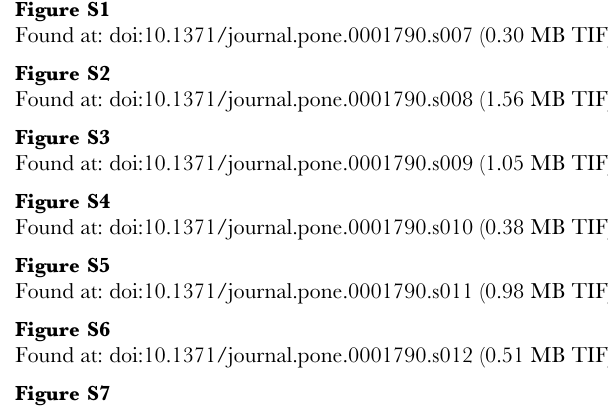
Figure S8 Found at: doi:10.1371/journal.pone.0001790.s014 (0.93 MB TIF) Figure S9 Found at: doi:10.1371/journal.pone.0001790.s015 (0.72 MB TIF) Figure S10 Found at: doi:10.1371/journal.pone.0001790.s016 (0.30 MB TIF)